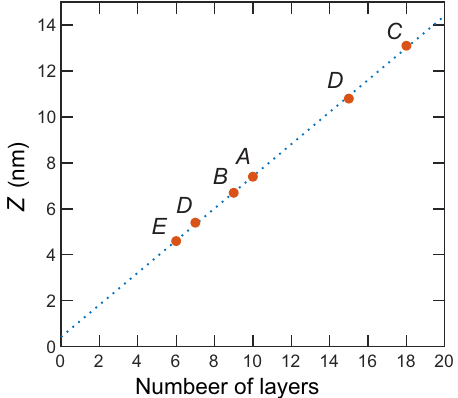
FIG. 6. Rabi contrast versus temperature. The Rabi contrast of the ensemble NV sample used in these experiments reaches a minimum at approximately 30 K.